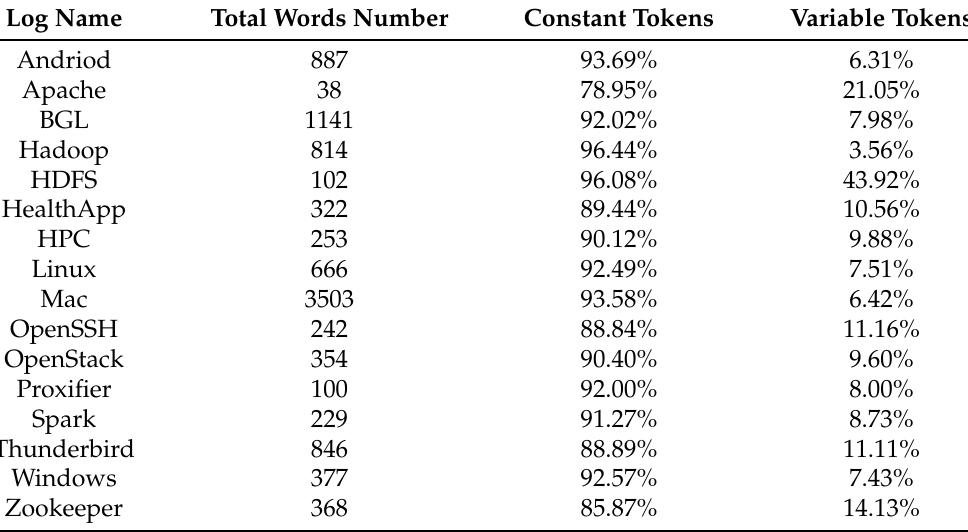
Table 3. The Ratio of The Number of Constants and Variables in Log